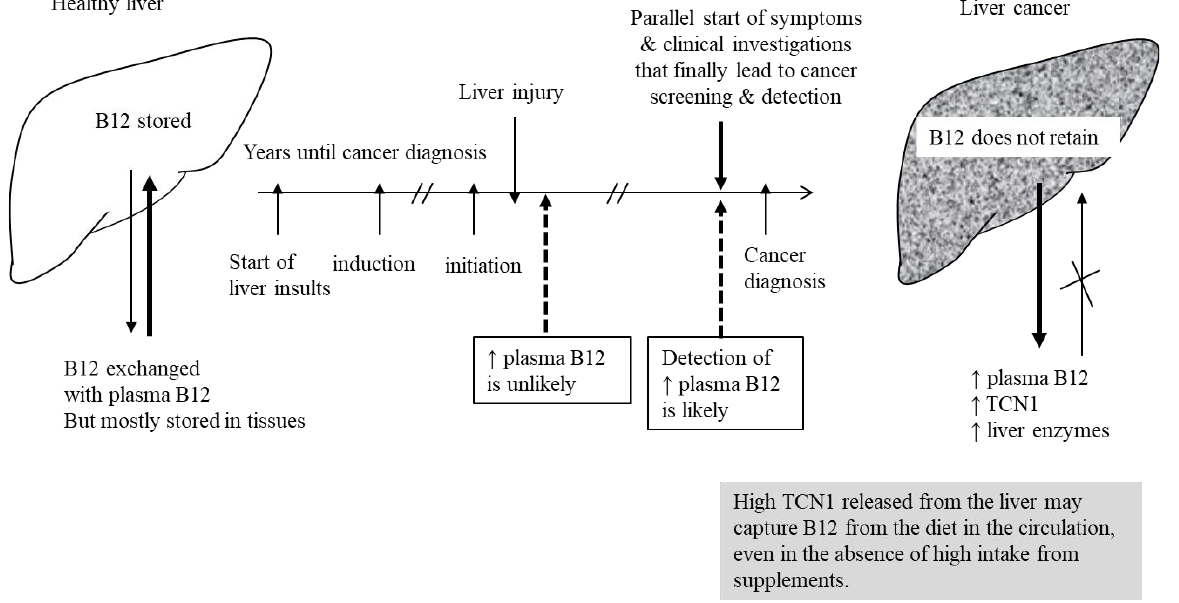
Figure 1. Disturbed physiology of vitamin B12 in patients with liver cancer leading to high concentrations of B12 in plasma. trations of B12 in